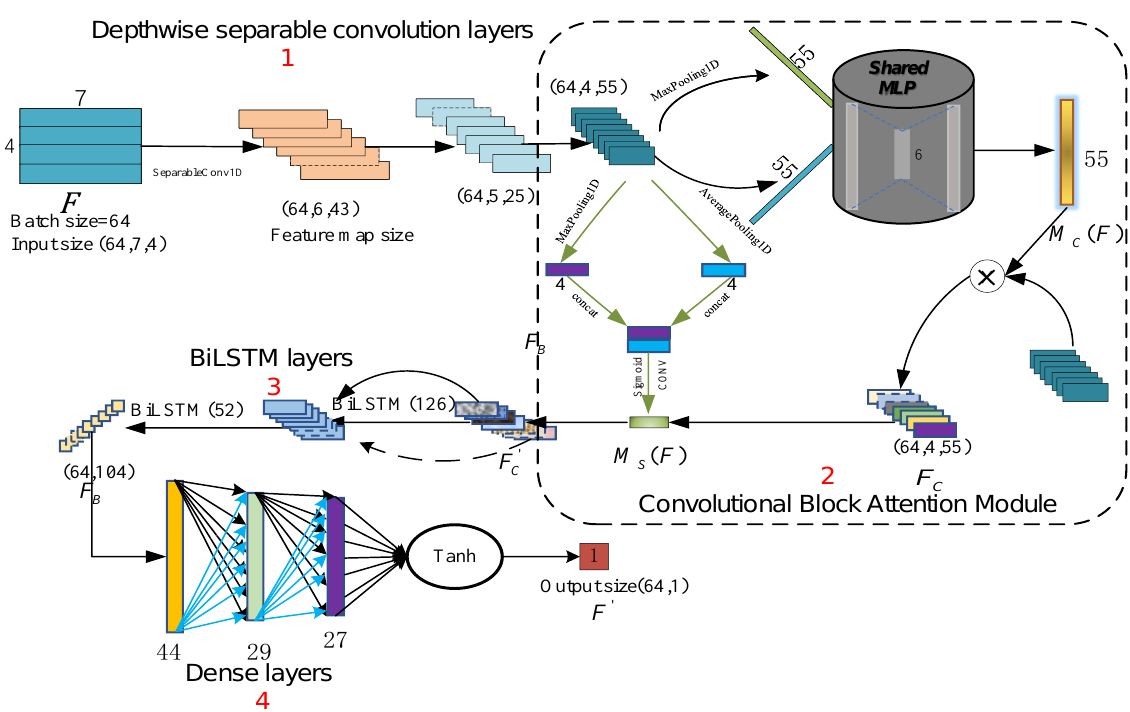
Figure 9. Spatiotemporal correlation prediction model with attention mechanism.